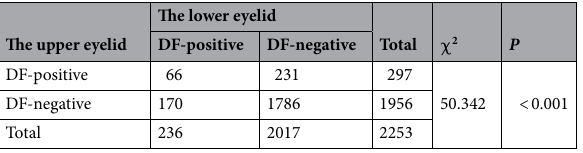
Table 2. The Demodex folliculorum (DF) prevalence of the upper and lower eyelids [number].